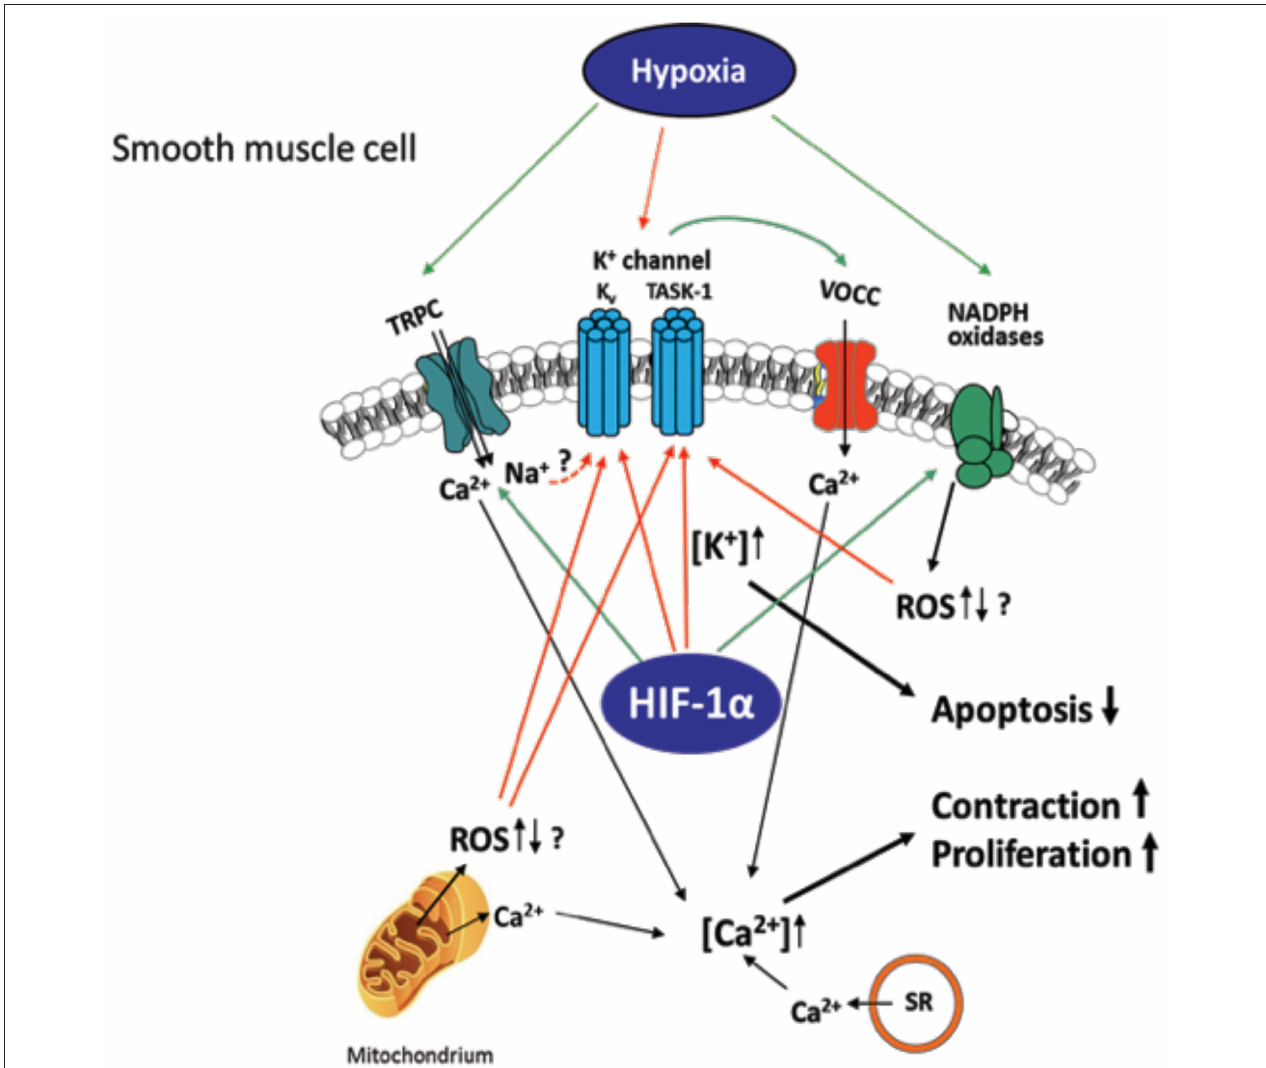
FIGURE 2 | Hypoxia-induced ion channel-mediated increase in proliferation, contraction, and decrease of apoptosis of SMCs contributing to pulmonary vascular remodeling. K v and TASK-1 channels are downregulated and less active after chronic hypoxia leading to accumulation of K + within the cell (mediating apoptosis-resistance) and membrane potential depolarization of the SMCs. This depolarization causes opening of voltage-operated Ca 2 + channels (VOCC), especially L-type channels, which mediate Ca 2 + entry. Hypoxia-dependent ROS regulation derived from NADPH oxidases and/or mitochondria is suggested to inhibit the K + channels, although it is unclear whether an increase or decrease of ROS occurs in hypoxia. Transient receptor potential channels (TRPC)-mediated Ca 2 + or Na + influx (speculatively by gating K + channels) was also shown to be essential for the intracellular Ca 2 + increase in at least acute hypoxia. Ca 2 + release from mitochondria and sarcoplasmic reticulum (SR) was shown to additionally increase Ca 2 + within the cell. Thus, mediated contraction and proliferation of the SMCs can contribute to vascular remodeling. Colored arrows depict either activation (green) or inhibition